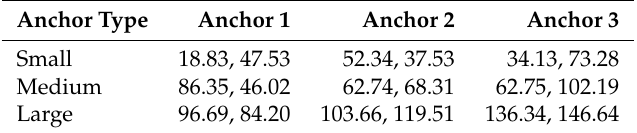
Figure 10. Selected anchors using K-Means clustering algorithm. Different colors denote distinct anchor groups responsible for detecting objects in the spread. Table 3. Anchor scales in pixels calculated using the K-Means clustering